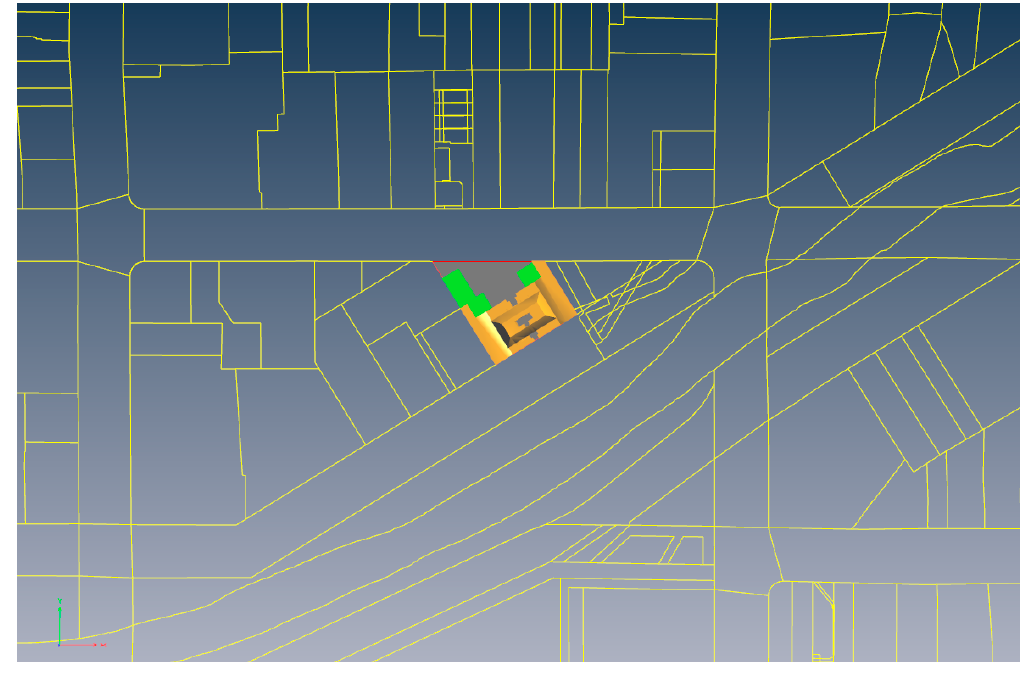
Figure 9. Plan view of 3D parcels against the 2D parcel fabric.